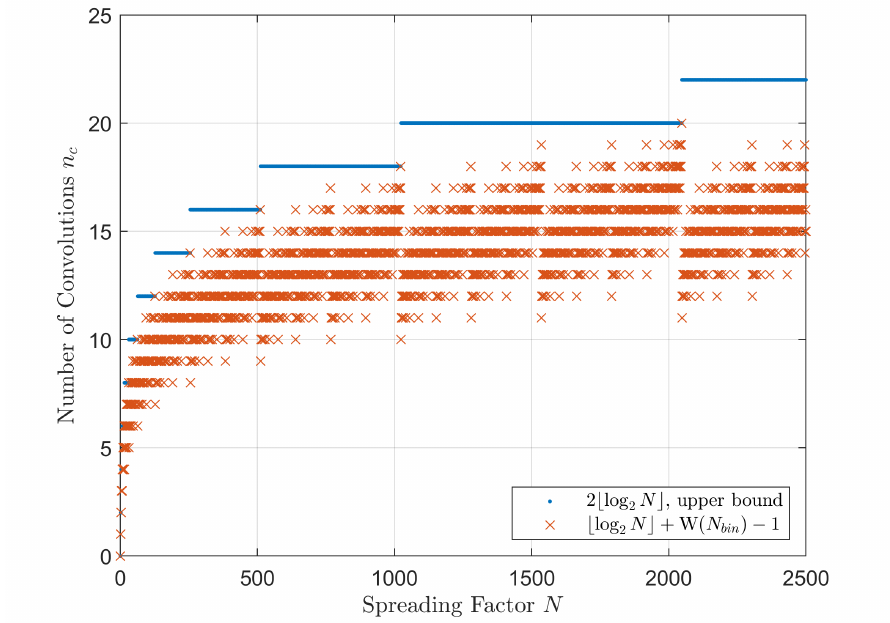
Figure 12. Uncoded GDSS BER computation: number of numerical convolutions n c and its upper bound, versus spreading factor N